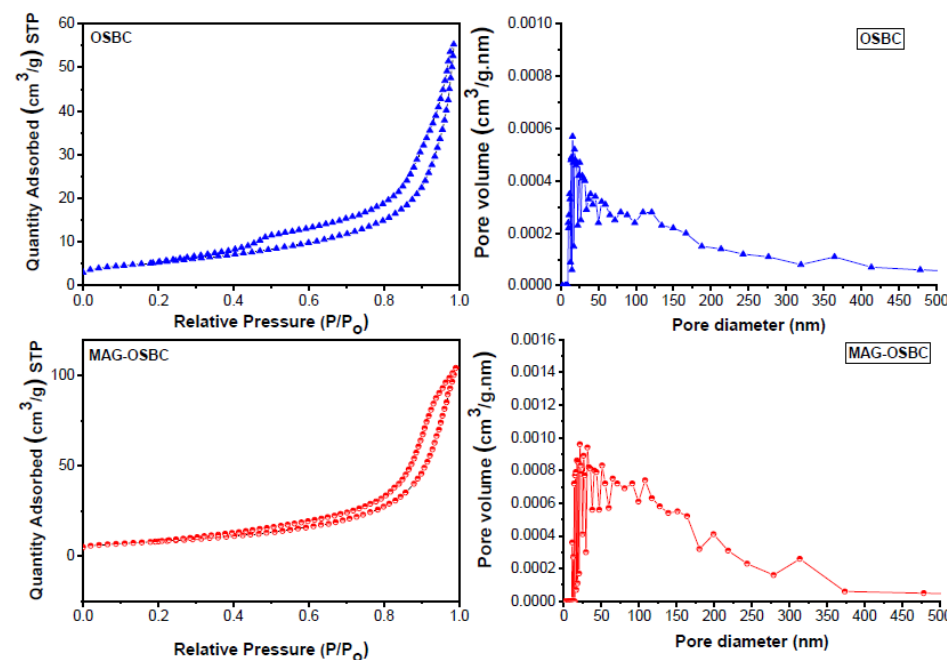
Figure 4. Nitrogen adsorption–desorption isotherms for the prepared